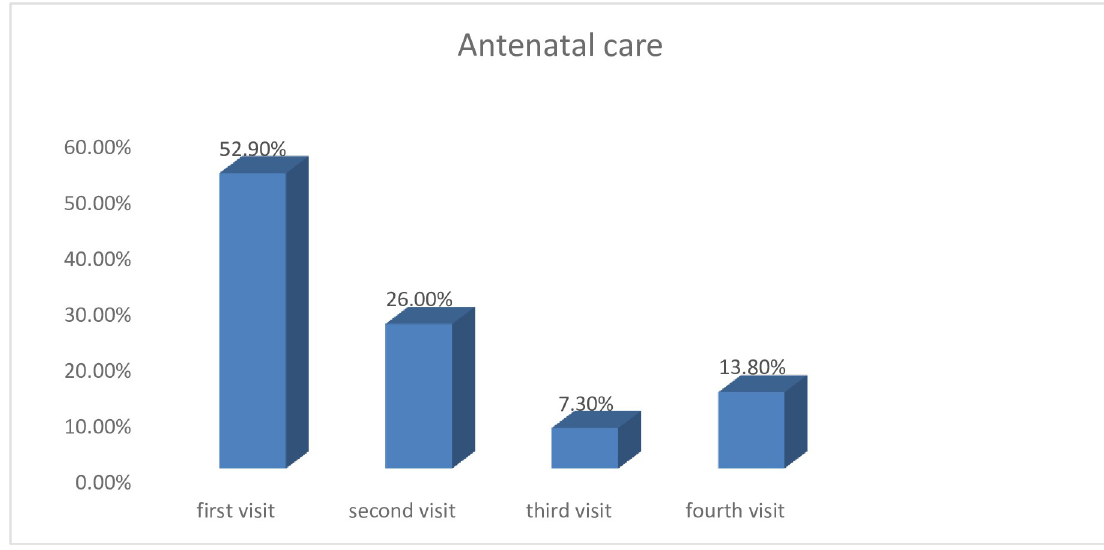
Fig 1. Antenatal care status of pregnant mothers at South Omo Zone hospitals, Southern Ethiopia, 2021.